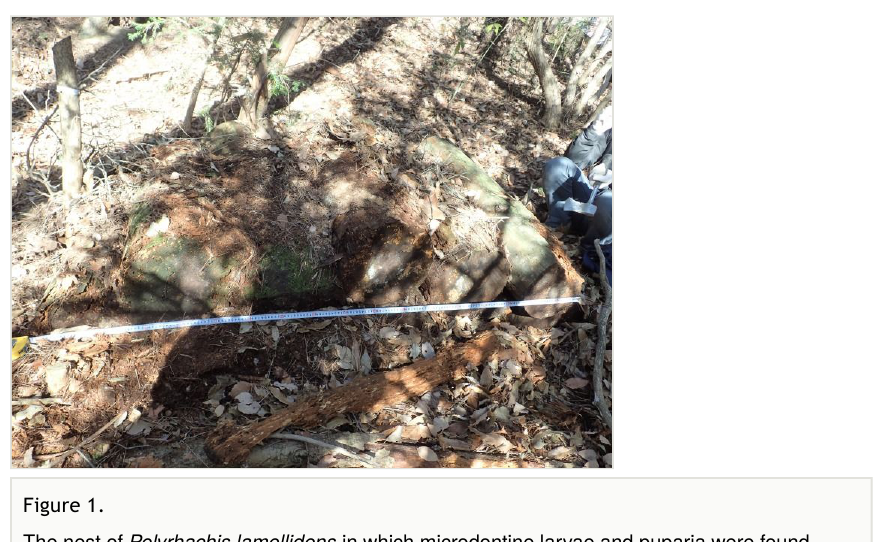
(Fig. 1). Each tree was approximately 100 cm in length and 20 to 50 cm in diameter.